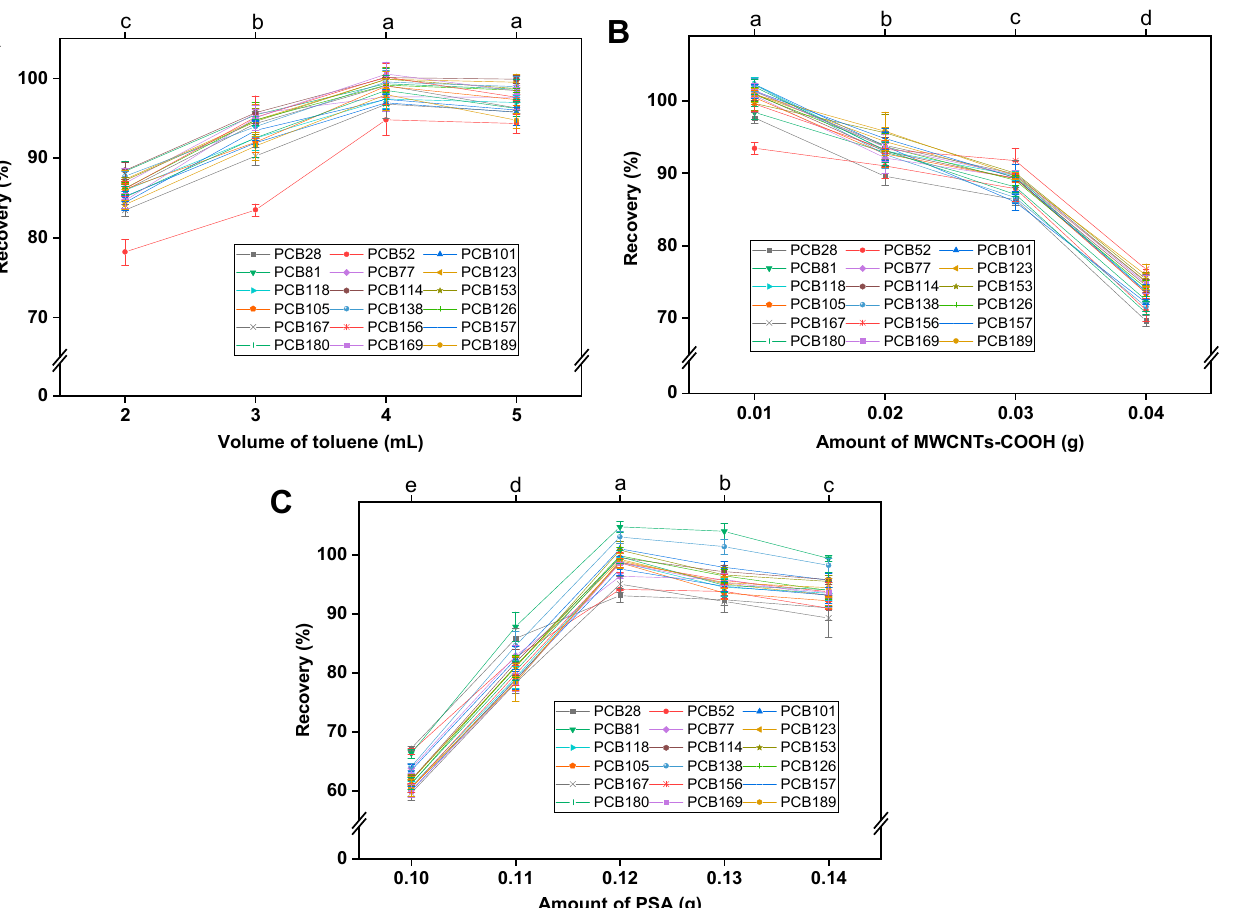
Figure 5. Effects of ( A ) volume of toluene, ( B ) amount of MWCNTs-COOH, and ( C ) amount of PSA on purification performance ( n = 3). Different lowercase letters indicate significant differences at p < 0.05 under different treatments.